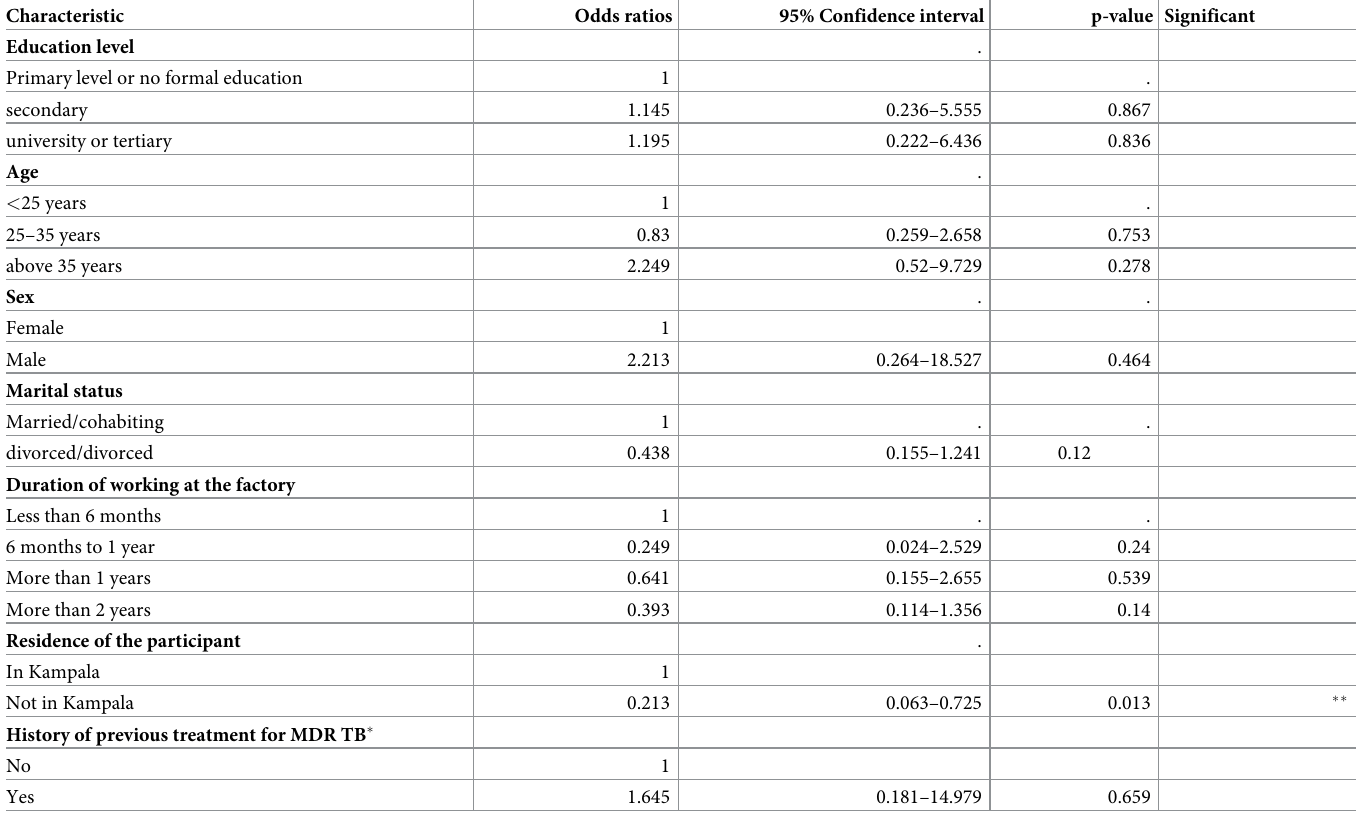
Table 5. Regression analysis for factors associated with hearing